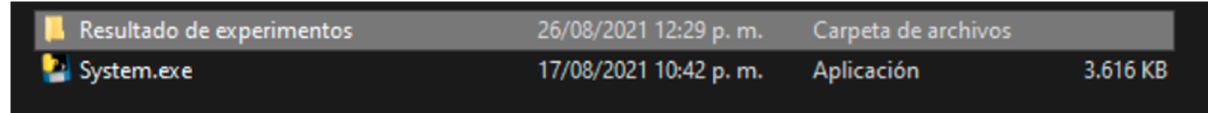
Figure 8. Information about block termination.